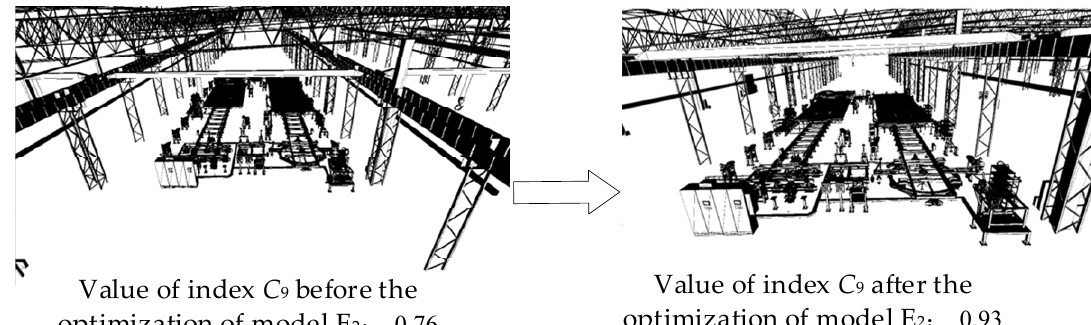
Figure 11. Comparison results of the number of abnormal indexes before and after quality control.